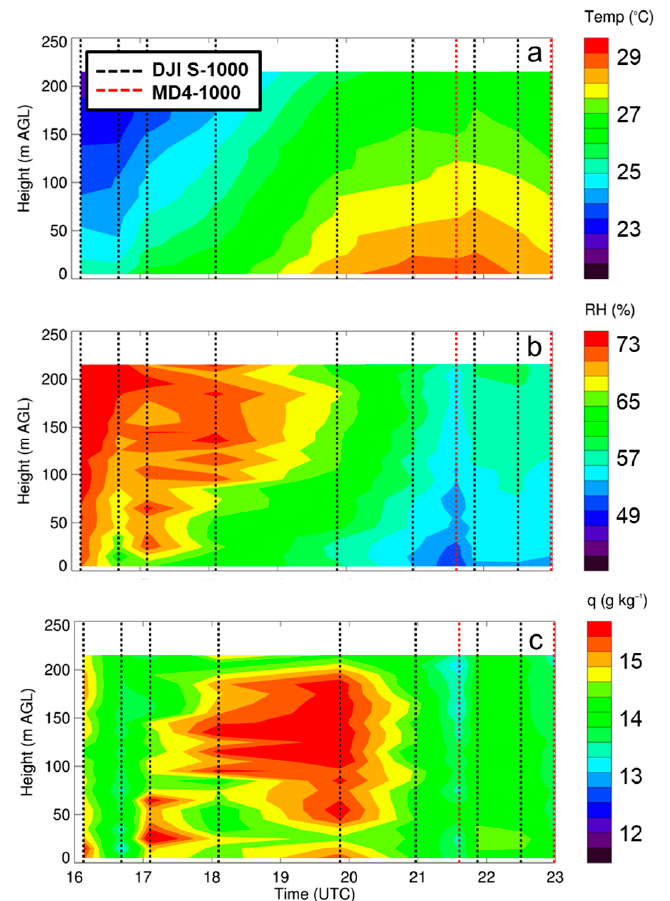
Figure 8. Evolution of temperature ( a ), relative humidity ( b ), and specific humidity ( c ) at Cullman, AL on 28 April 2017 obtained from the DJI S-1000 and MD4-1000 sUAS. Black and red dashed vertical lines represent profiles made by the DJI S-1000 and MD4-1000 sUAS, respectively.